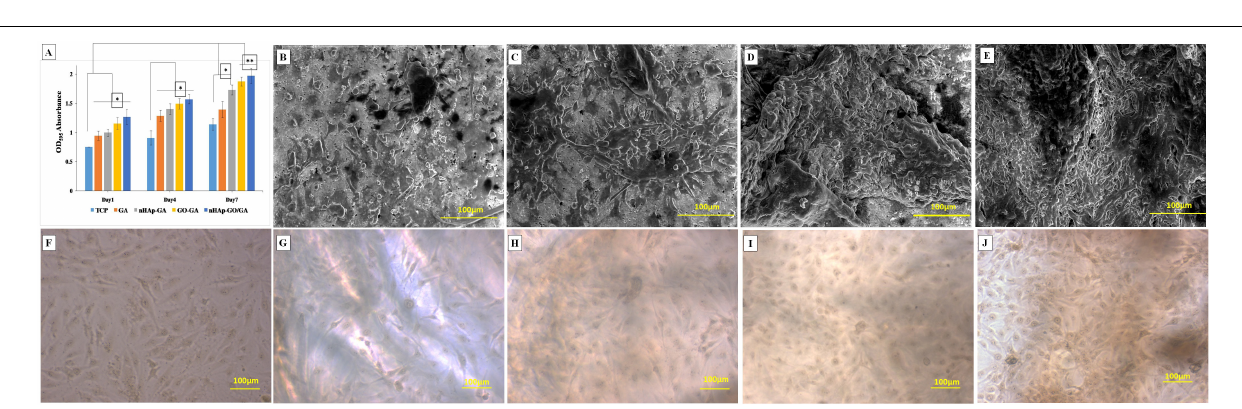
Frontiers in Materials |